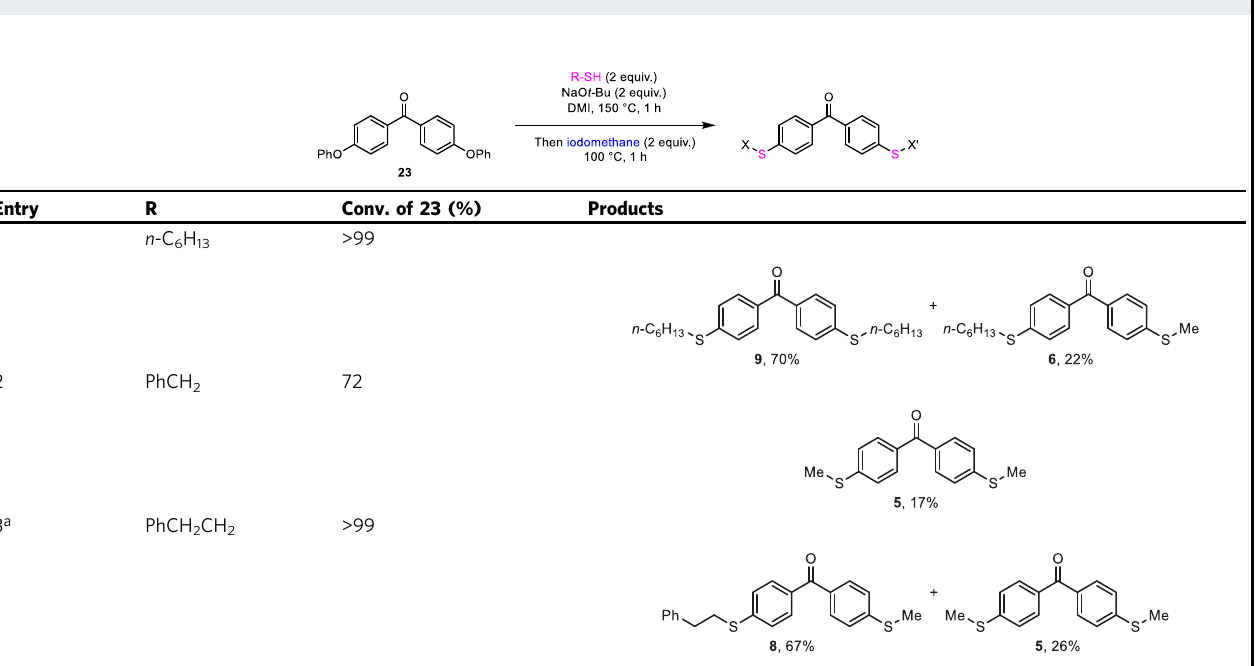
Table 2 Examination of the effect of thiols using a model substrate.